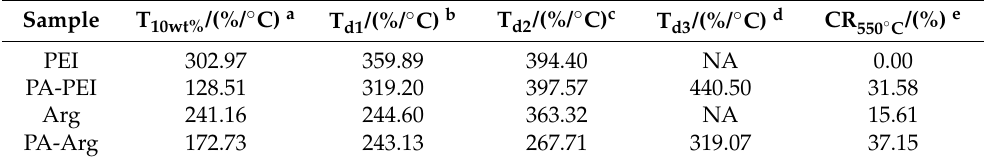
Table 2. TGA and DTG data of PEI, PA-PEI, Arg, and PA-Arg materials under N 2